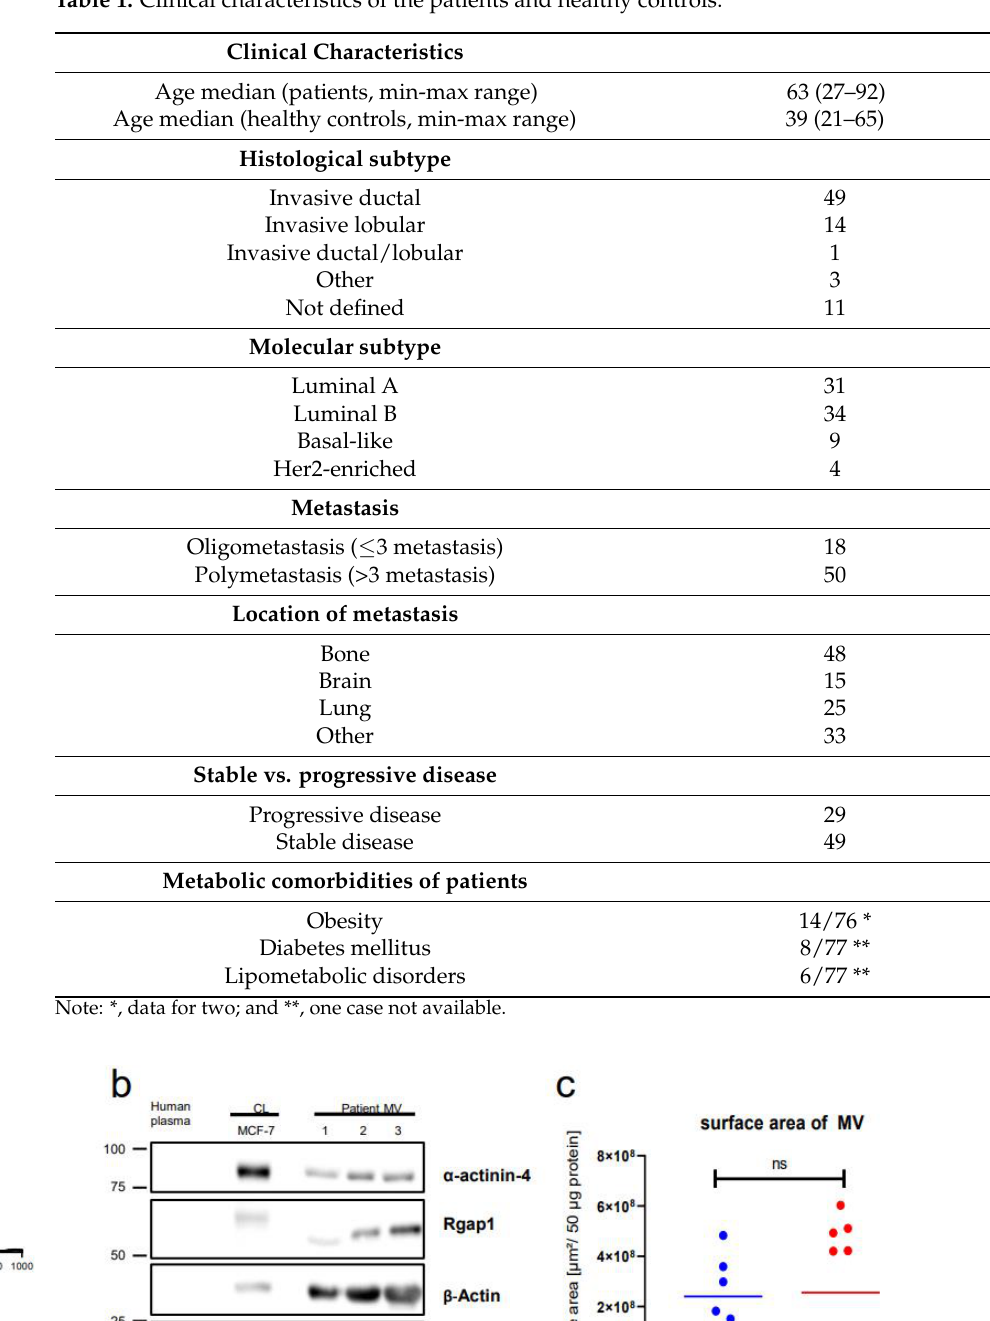
Table 1. Clinical characteristics of the patients and healthy controls.